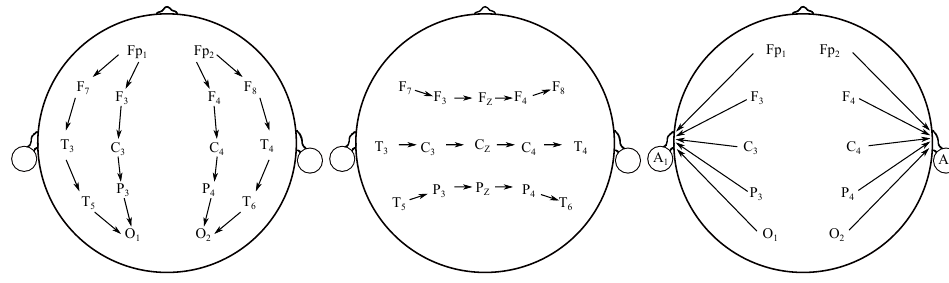
( a ) Bipolar longitudinal montage. ( b ) Transverse bipolar montage. ( c ) Referential ear montage. Figure 2. Various EEG